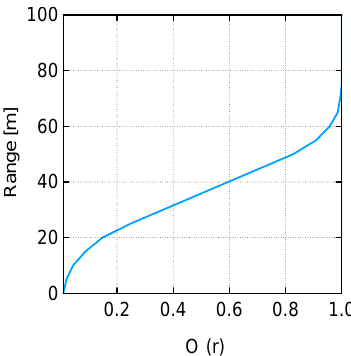
Figure 5. Manufacturer-deduced overlap function of Vaisala CL31 ceilometers using firmware versions 1.71, 1.72, 2.02, or 2.03 (older versions used an overlap function with 5 to 10% lower overlap val- ues). The function, applied in the lowest range gates above the in- strument, is derived from laboratory measurements and field ob- servations under homogeneous atmospheric conditions. During the production process, the applicability of the overlap function is veri- fied for each unit. Due to the stable instrument conditions (e.g. low internal temperature variations), Vaisala expects no systematic vari- ations of the overlap function. The error is stated to be below